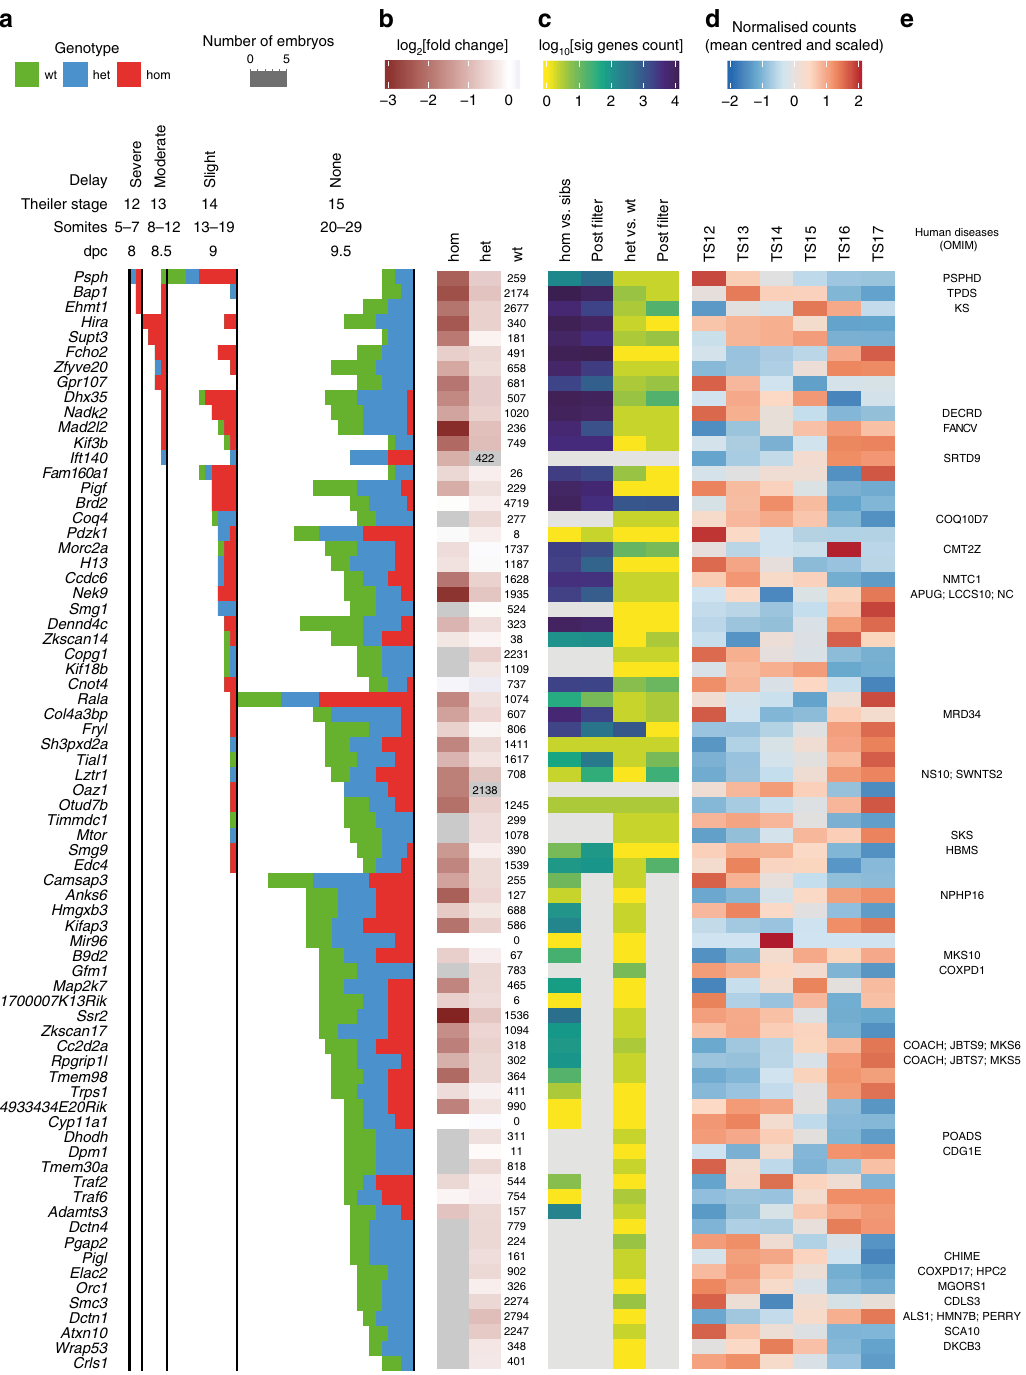
Fig. 4 Summary of mutant lines. a Diagram of the stages of embryos collected coloured by genotype (green = wild type, blue = heterozygous, red = homozygous). The horizontal length of the bars represents the number of embryos at each Theiler stage for each genotype. The mutant lines are arranged from top to bottom by decreasing amount of delay. Lines are categorised by the most delayed embryos collected (TS12 = Severe, TS13 = Moderate, TS14 = Slight, TS15 = None). For two of the lines ( Ift140 and Oaz1 ), homozygous and heterozygous embryos were collected, but no wild-type siblings were present. b Heatmap of expression relative to wild-type (log 2 [fold change]) of the targeted gene itself (hom = homozygous vs. wild type, het = heterozygous vs. wild type). The numbers in the wt column are mean normalised counts in the wild-type embryos for comparison (except for Ift140 and Oaz1 where the mean counts are for the het embryos). c Heatmap of the number of genes called as signi fi cantly differentially expressed (DE; log 10 scaled). hom vs. sibs = homozygous embryos compared to siblings (heterozygous and wild-type), het vs. wt = heterozygous compared to wild-type embryos. Columns labelled post- fi lter show the numbers of DE genes after the delay analysis was applied for delayed lines. Grey boxes are where no comparison was done, for example, where no homozygous embryos were recovered or the delay analysis was not applied because the line was not delayed. d Expression of the targeted gene in the wild-type baseline averaged by Theiler stage and displayed as mean centred and scaled normalised counts. e Human syndromes (Online Mendelian Inheritance in Man) associated with the targeted gene. Source data are provided as a Source Data fi